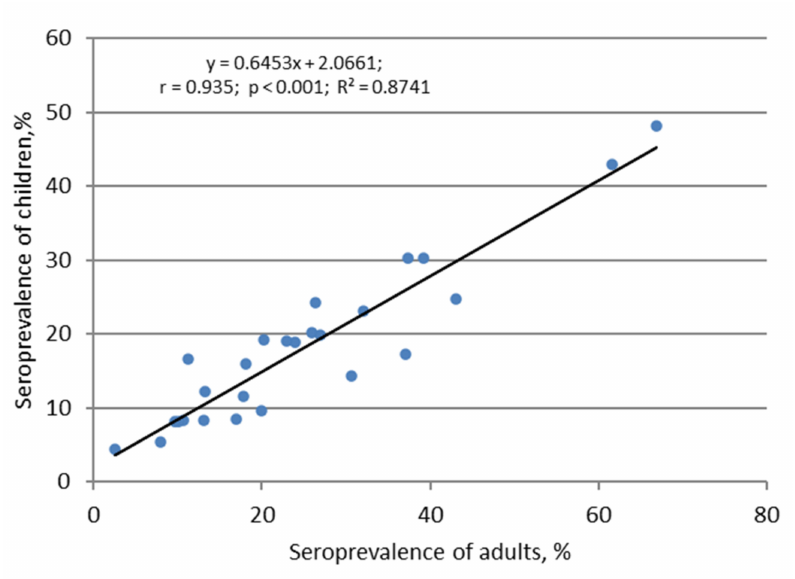
Figure 3. Correlation relationship between seroprevalence in children and adults. The regression equation, Spearman correlation coefficient (r), reliability of statistical relationship ( p ), and the coeffi- cient of determination R 2 are shown.